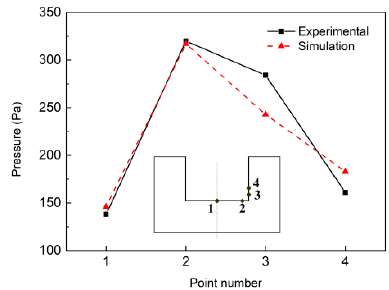
Figure 10. Comparison between simulated and experimental arc pressure of four points, experimental data from [7].